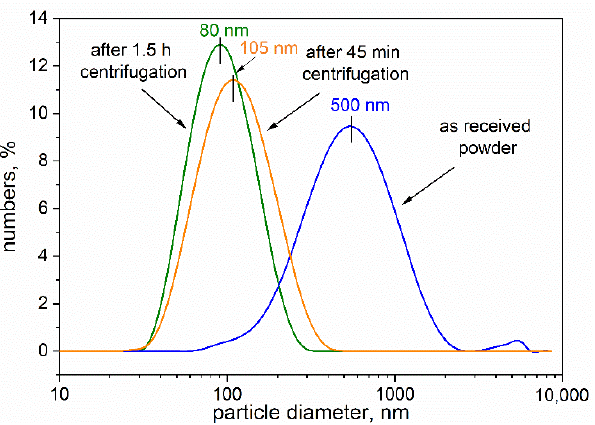
Figure 3. Particle size distributions of the ground boron carbide powders and the fraction after 45 min and 1.5 h centrifugation measured using dynamic light scattering technique.